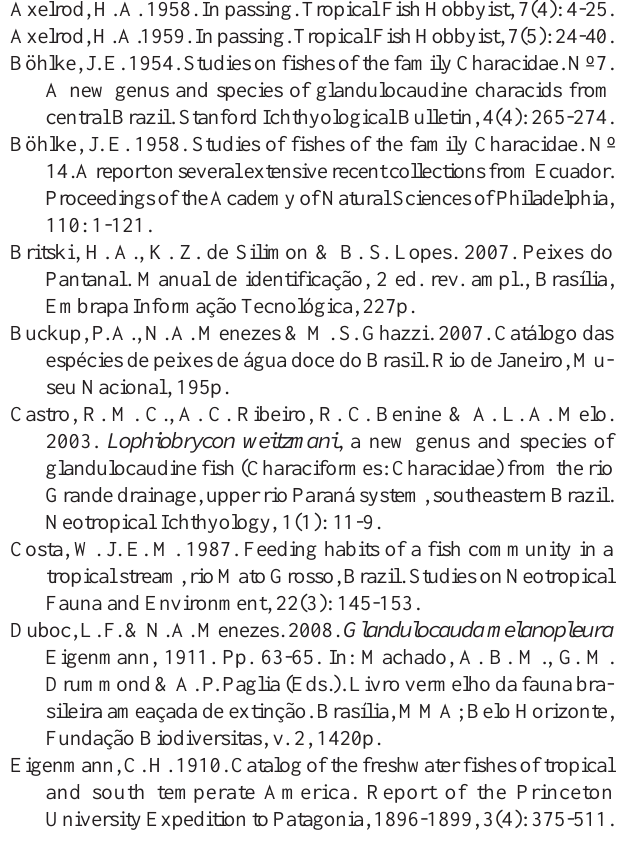
Figs. 48-50, Kelly Mautari (MZUSP) Figs. 6 and 7, Eduardo Baena (MZUSP) Fig. 8, and Alexandre C. Ribeiro (MZUSP) Figs. 3-5. Field assistance was provided by N. Labbish